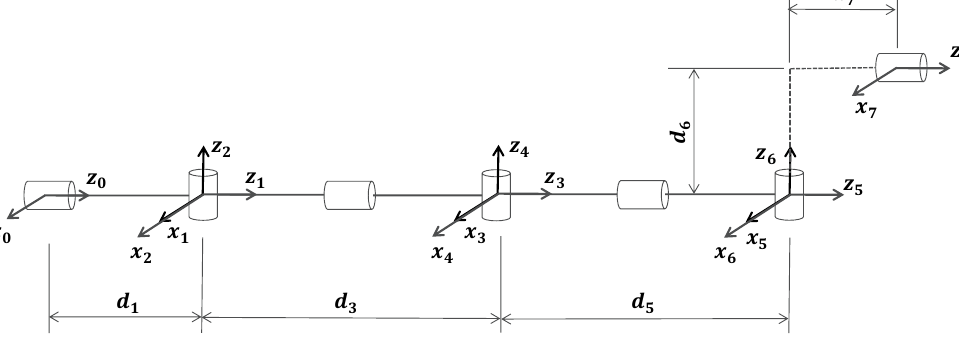
Figure 3. The improved D-H model. Table 1. The D-H parameters of the 6-DOF subchain of the improved kinematics model in Figure